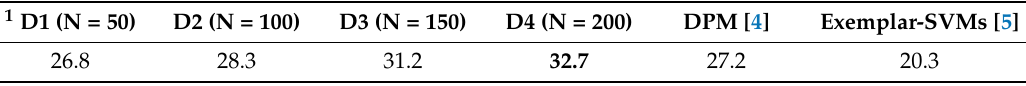
Figure 8. ( a ) Illustration of the detection accuracy between our trained detectors (detector 1–4) and other models (DPM and exemplar-SVMs); and ( b ) the precision-recall curve. Table 3. Comparison of three methods in partially-occluded object detection (%).